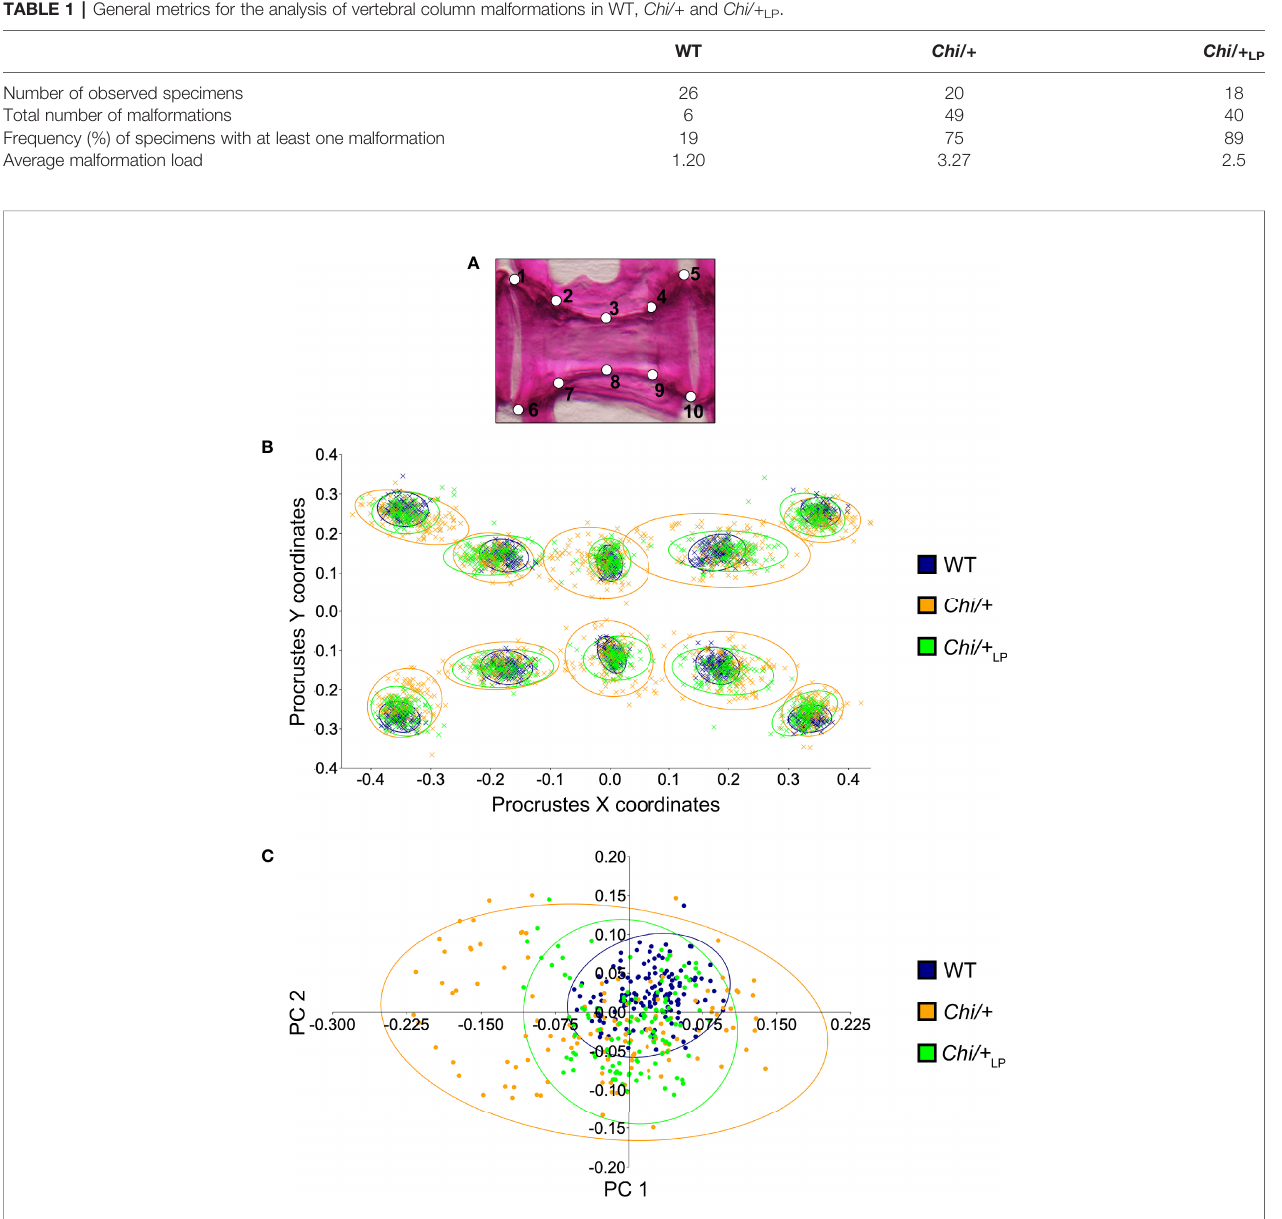
FIGURE 2 | Vertebral body shape variation in Chi/+ and Chi /+ LP mutants. (A) Alizarin red S stained vertebral body of a WT animal with 2D landmark positions used for quantifying the shape variation by means of geometric morphometrics, represented in (B) . (B) The scatterplot of WT, Chi/+ and Chi /+ LP 2D landmarks shows high variation in the superimposition of X,Y Procrustes coordinates of Chi/+ compared to WT animals. Chi /+ LP animals display reduced landmark variation compared to Chi/+ and a distribution more similar to WT indicating a partial rescue of shape variation at three months of age. The fi rst 10 caudal vertebral centra in WT (n=15), Chi/+ (n=13) and Chi /+LP (n=12) were analysed. The 95% con fi dence ellipses are shown. (C) Principal component analysis of vertebral centra shapes. Each symbol in the plot represents a vertebral body. PC indicates Principal Component and the values in the axis labels indicate the percentage of variation accounted for by each axis. Chi/+ animals show high variance compared to WT animals ( Chi/+ versus WT, PC1 0.3321, PC2 0.1795; Chi-square test: p < 0.001). Variance is rescued in Chi /+ LP animals ( Chi /+ LP versus WT, PC1 0.2484, PC2 0.2020; Chi-square test: non-signi fi cant). The 95% con fi dence ellipses are shown.